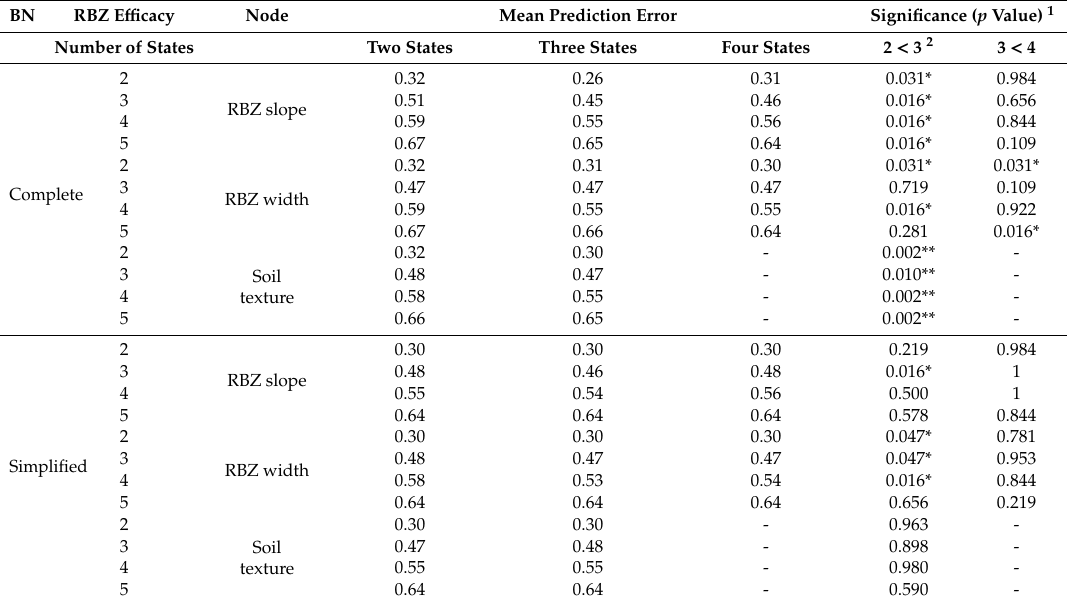
Table 3. E ff ect of the state number of parent nodes on prediction errors for di ff erent BNs. Mean errors and p values based on the outcomes of six BNs (RBZ width, RBZ slope) and nine BNs (soil texture). The nodes “flow pathway” and “RBZ vegetation” in complete BNs have only two states and are not shown. BN RBZ E ffi cacy Node Mean Prediction